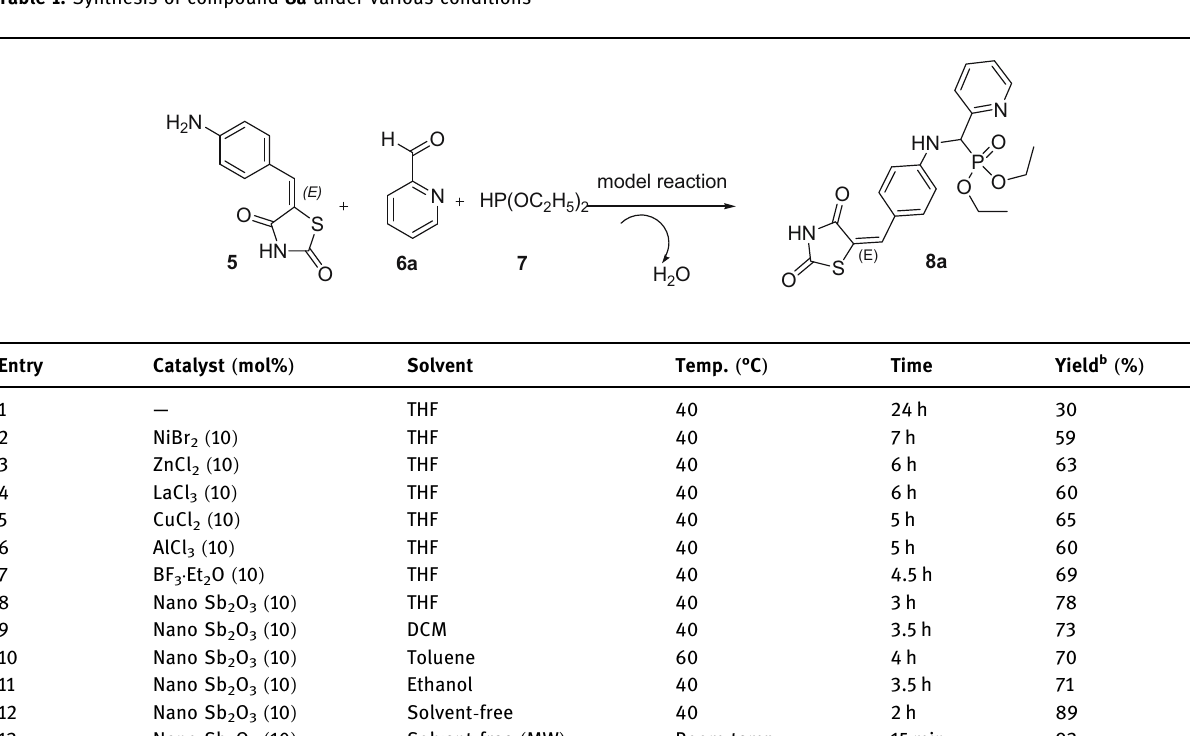
Table 1: Synthesis of compound 8a under various conditions